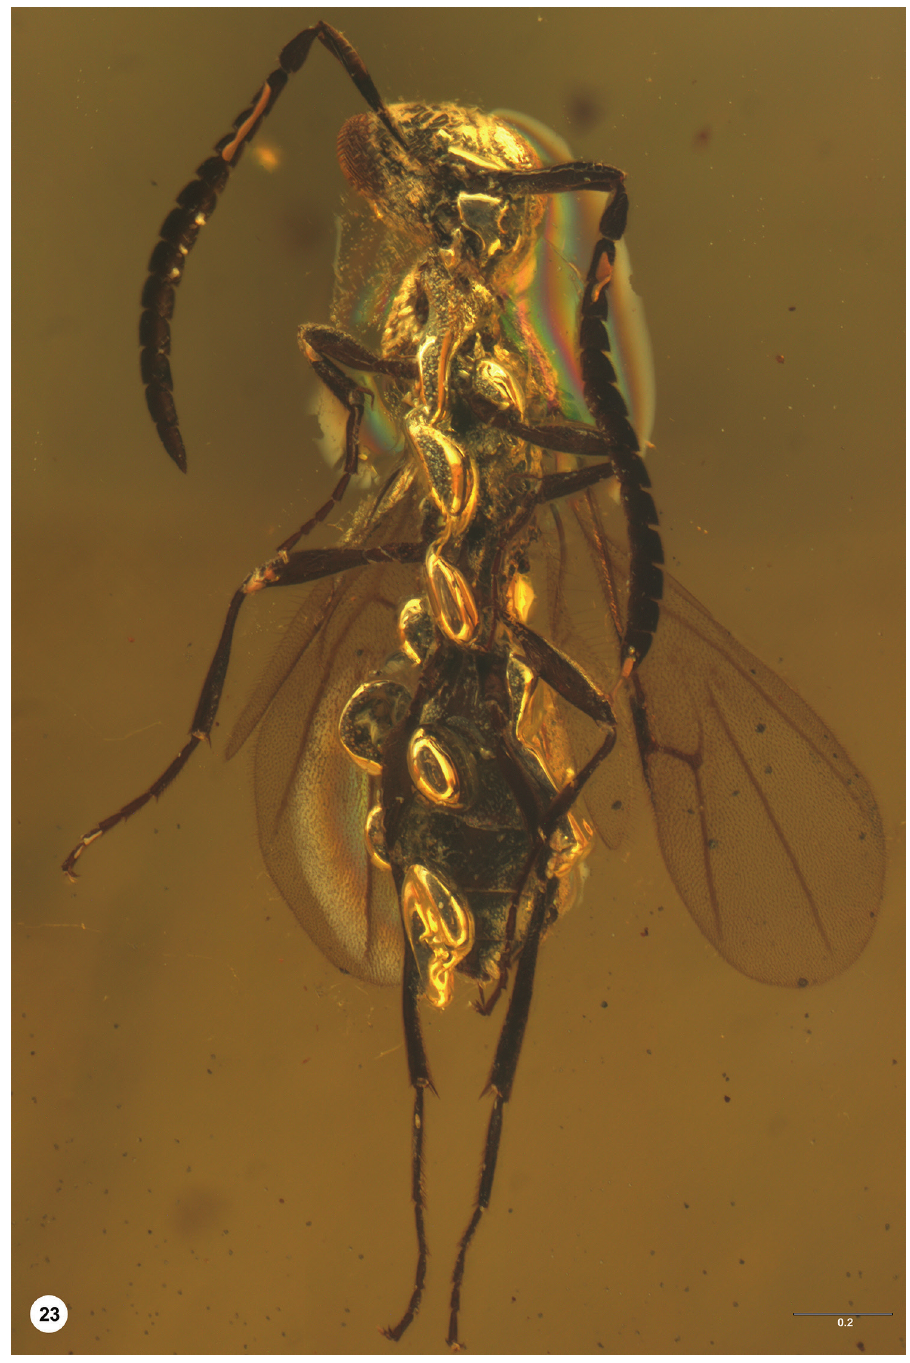
Figure 23. Proteroscelio nexus , female holotype (USNMENT01197245) habitus, ventral. Scale bar in